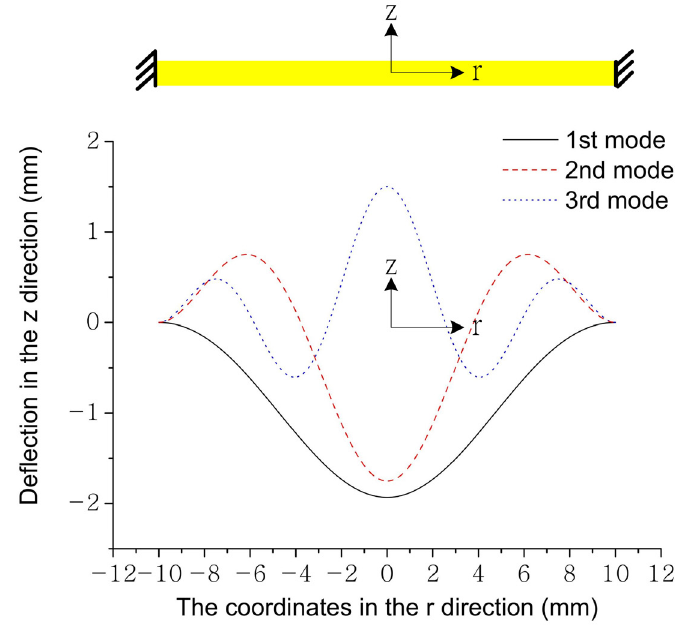
Table 1. The eigenvalues of the first three resonance frequencies for clamped-edge disk.